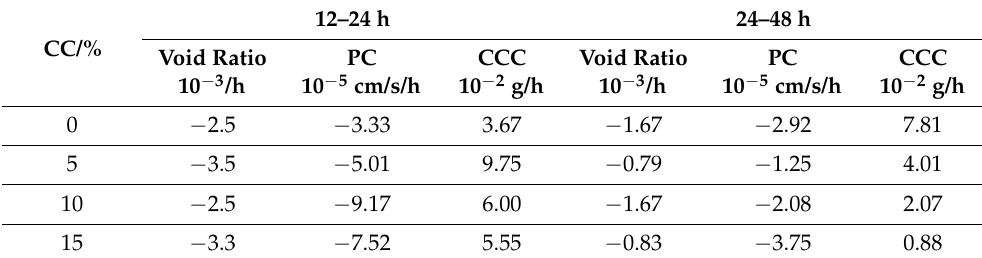
Table 3. Rate of void ratio, permeability, and CCC.